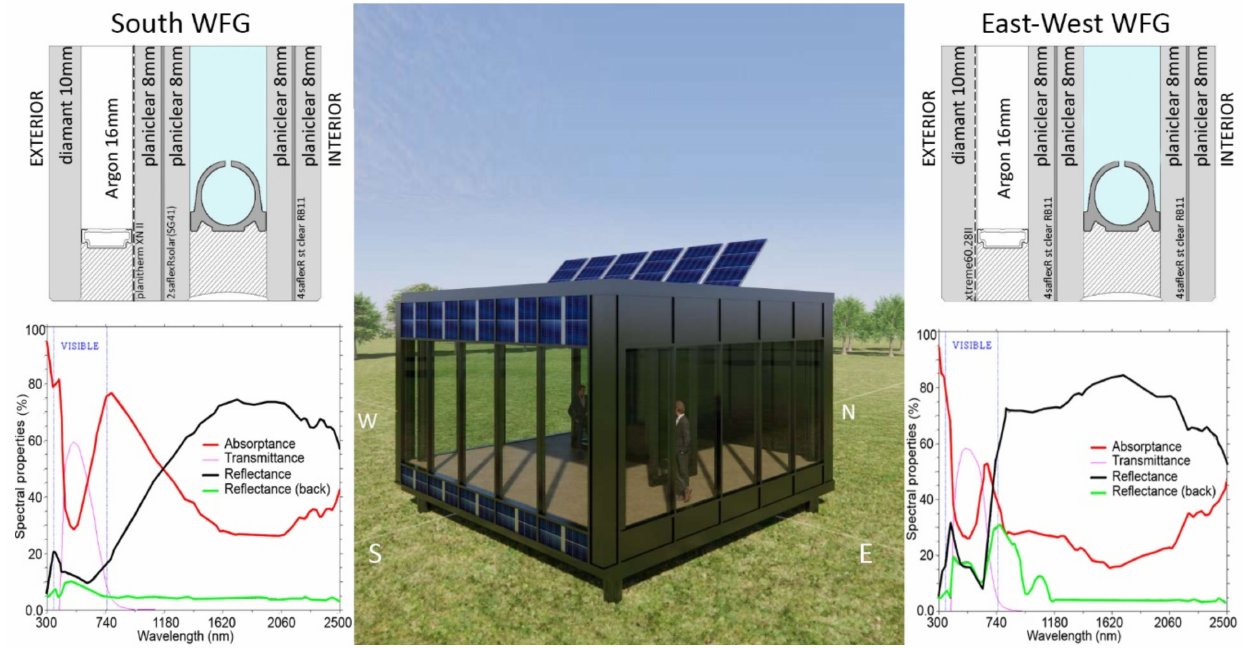
Figure 1. Description of Sophia’s prototype